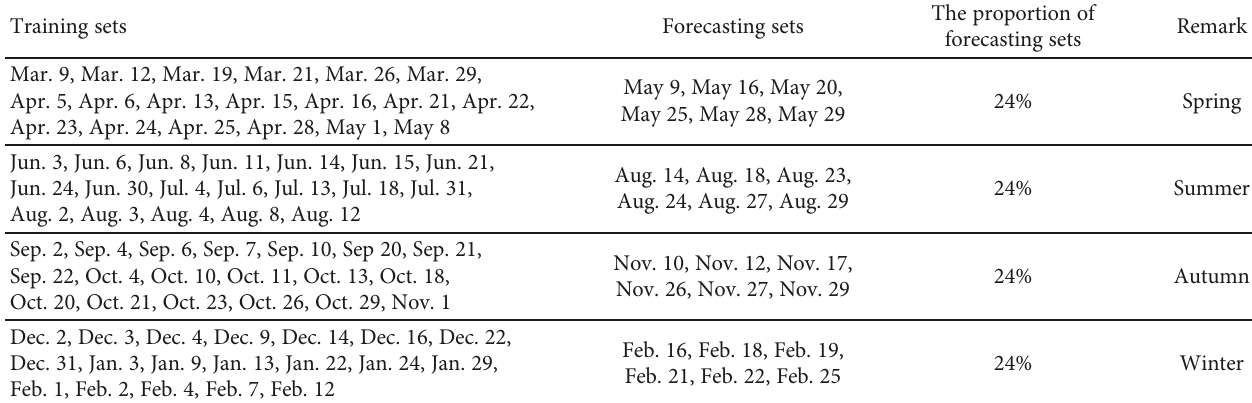
Table 1: Detailed description of the training and forecasting sets considered.